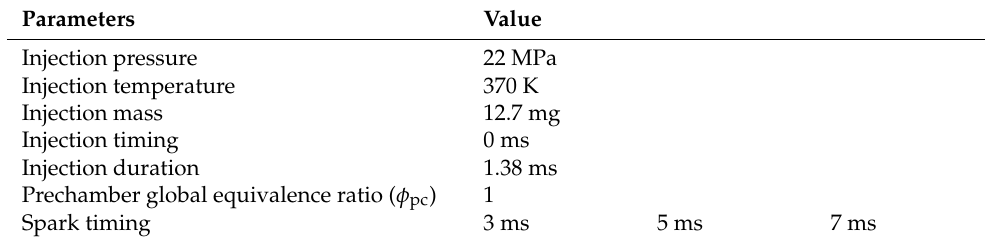
Table 4. The conditions for different spark timings.